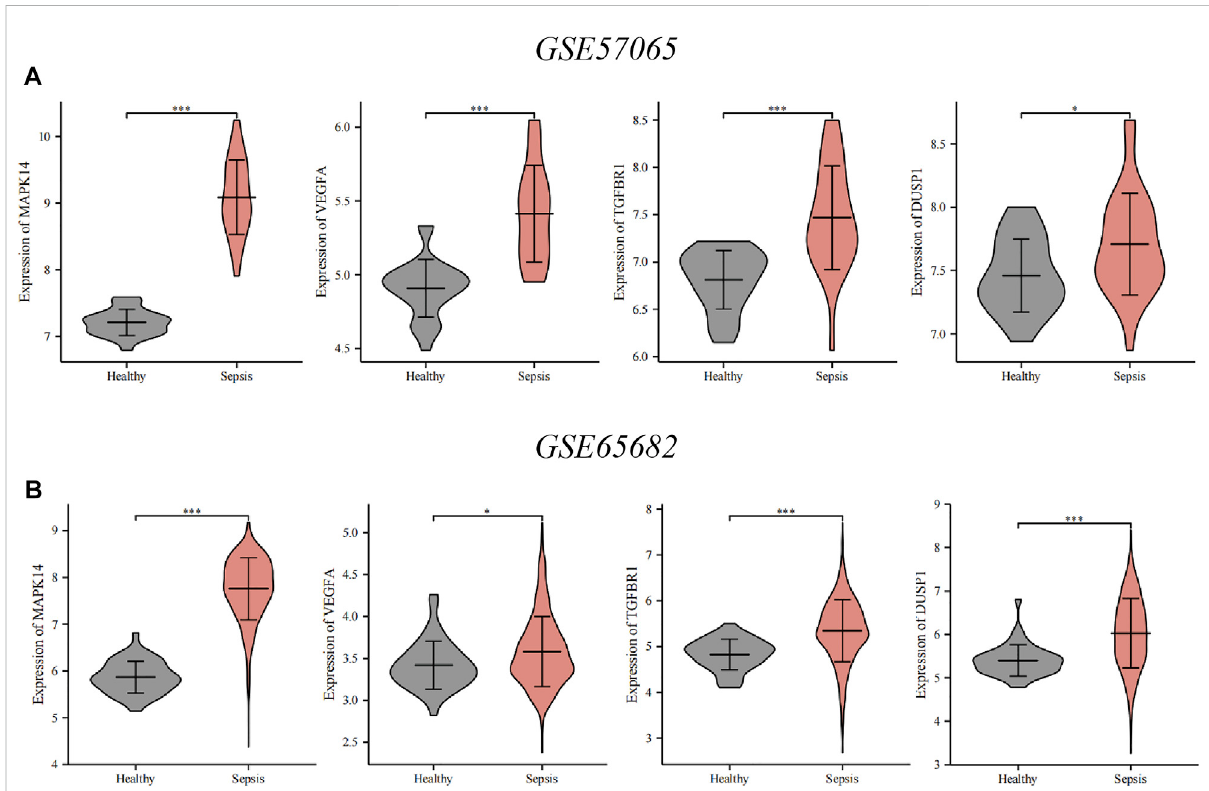
FIGURE 6 Veri fi cation of the key ferroptosis-related differentially expressed genes (DEGs) using datasets from the GEO database. (A) Veri fi cation by the GSE57065 dataset. Compared with healthy volunteers, expression of all key ferroptosis-related DEGs was upregulated in sepsis patients. (B) Veri fi cation by the GSE65682 dataset. Compared with healthy volunteers, expression of all key ferroptosis-related DEGs was upregulated in sepsis patients. ppp p < 0.001, pp p < 0.01, p p < 0.05, ns, no signi fi cant